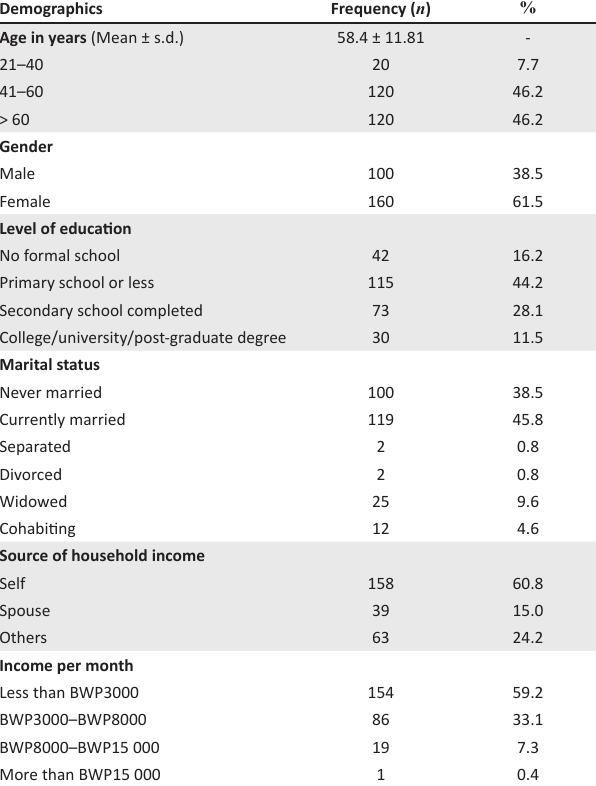
TABLE 1: Socio-demographic characteristics of study participants. Demographics